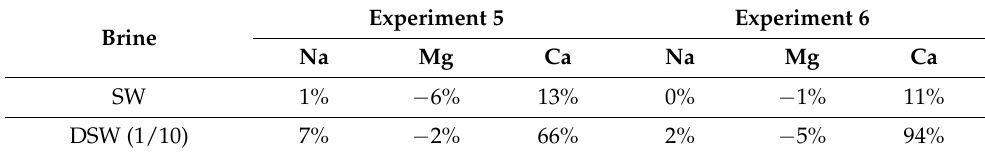
Table 6, the differences between the injected brine and steady-state effluent concentrations for SW and DSW (1/10) are presented. Table 6. Deviations between injected brine and steady-states effluent concentrations.